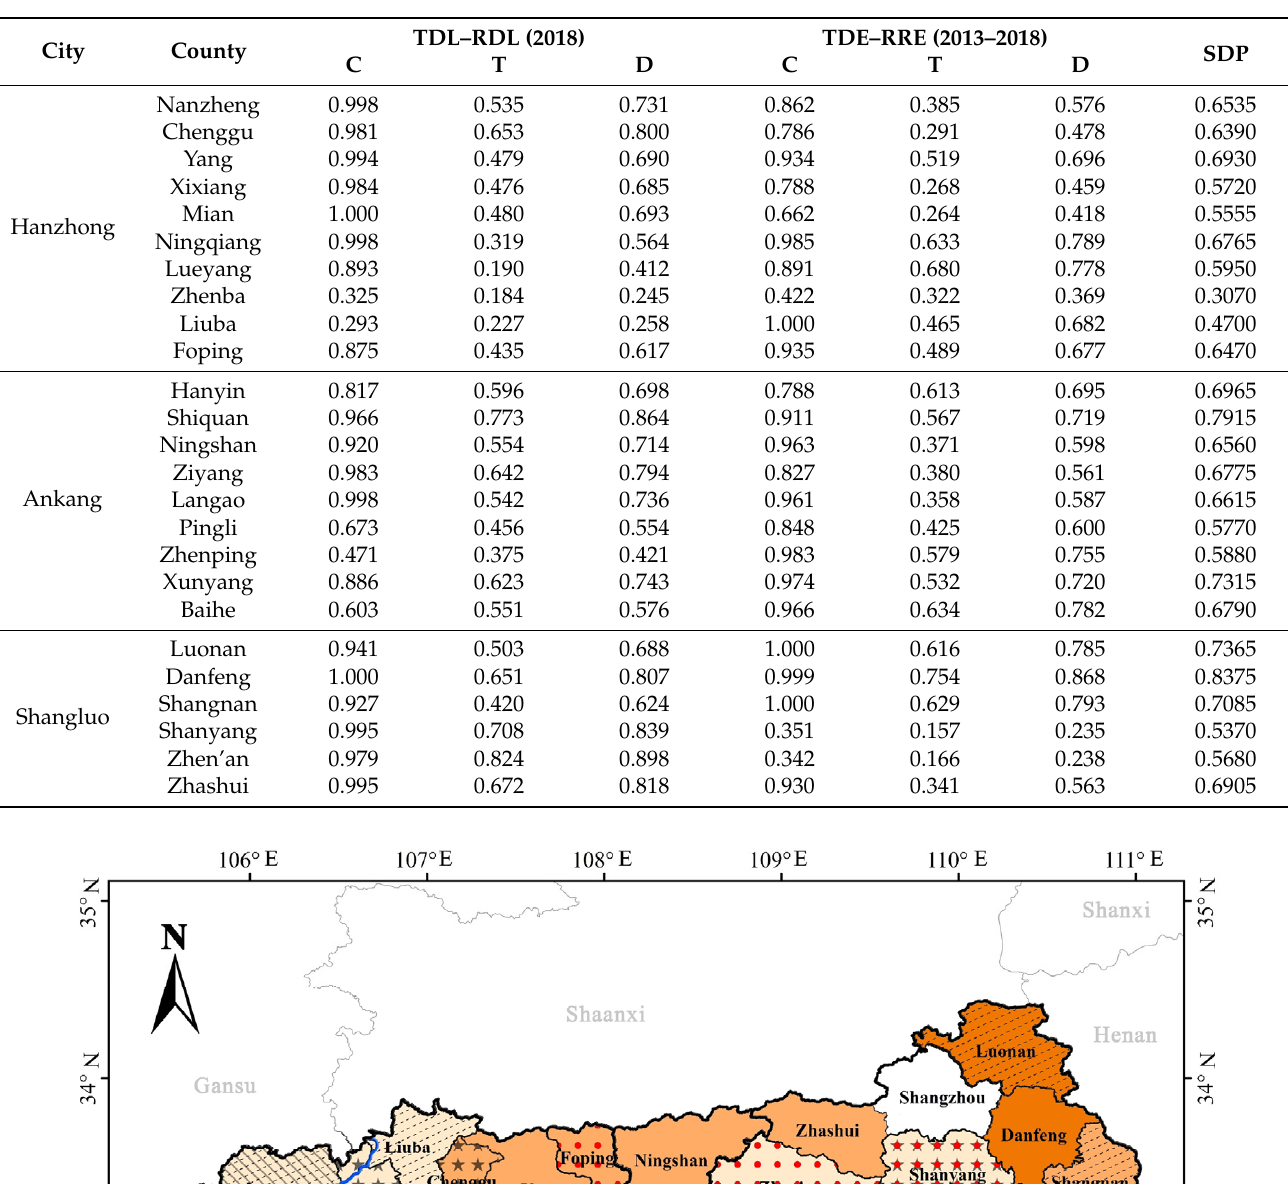
Table 2. The result of the SDP.